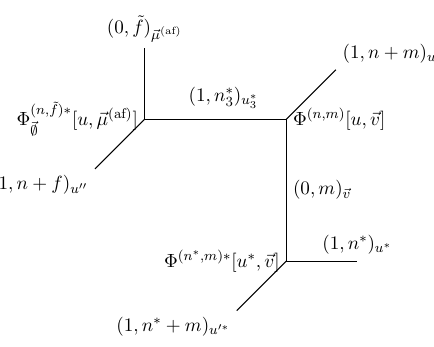
Figure 10 . Representation web of the A 1 quiver with antifundamental